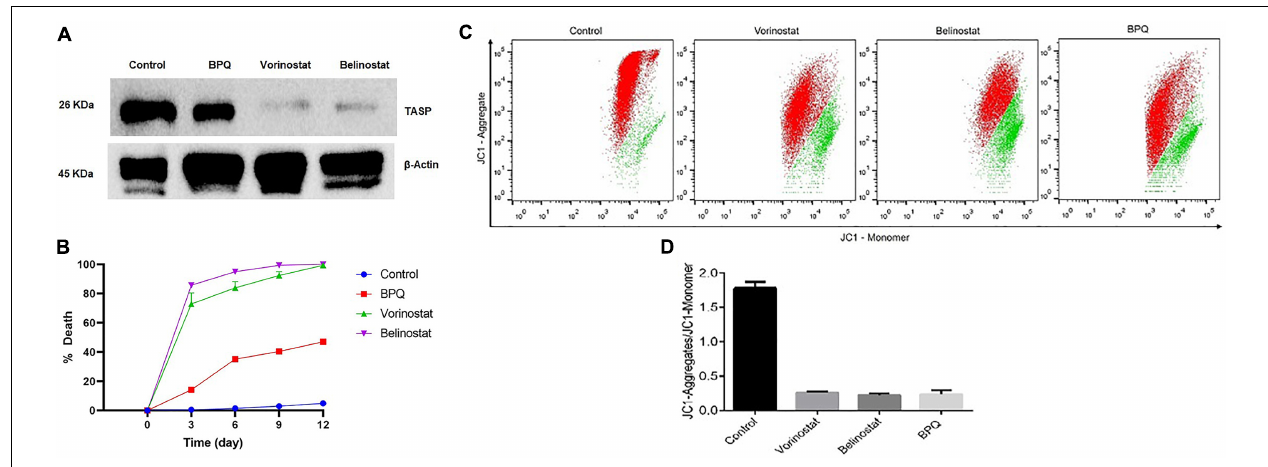
FIGURE 3 | Effect of Belinostat and Vorinostat on the parasite and its mitochondrial membrane potential: (A) Western blot analysis of the T. annulata infected cells treated with IC 50 concentrations of vorinostat and belinostat (after 48 h) and controls [without drug treatment and buparvaquone (BPQ) treatment] using mouse anti- TaSP antibody and mouse anti- β -actin as a loading control. (B) Reversibility of growth inhibition after treatment with histone deacetylase (HDAC) inhibitor. After 48 h, HDACi and BPQ drug pressure were removed, and parasite growth was monitored for 12 days in the traditional medium. The experiment was repeated thrice. (C) Flow cytometry analysis using JC1 dye to analyze vorinostat and belinostat effect on the mitochondrial membrane potential of T. annulata infected cells. Mitochondria depolarization was quantified by taking the ratio of red to green fluorescence emission intensity. The JC1-aggregate and the JC1-monomer are represented by red and green color, respectively, in the dot-plot. (D) The graph shows the ratio of JC1-aggregate and the JC1-monomer from the flow cytometer